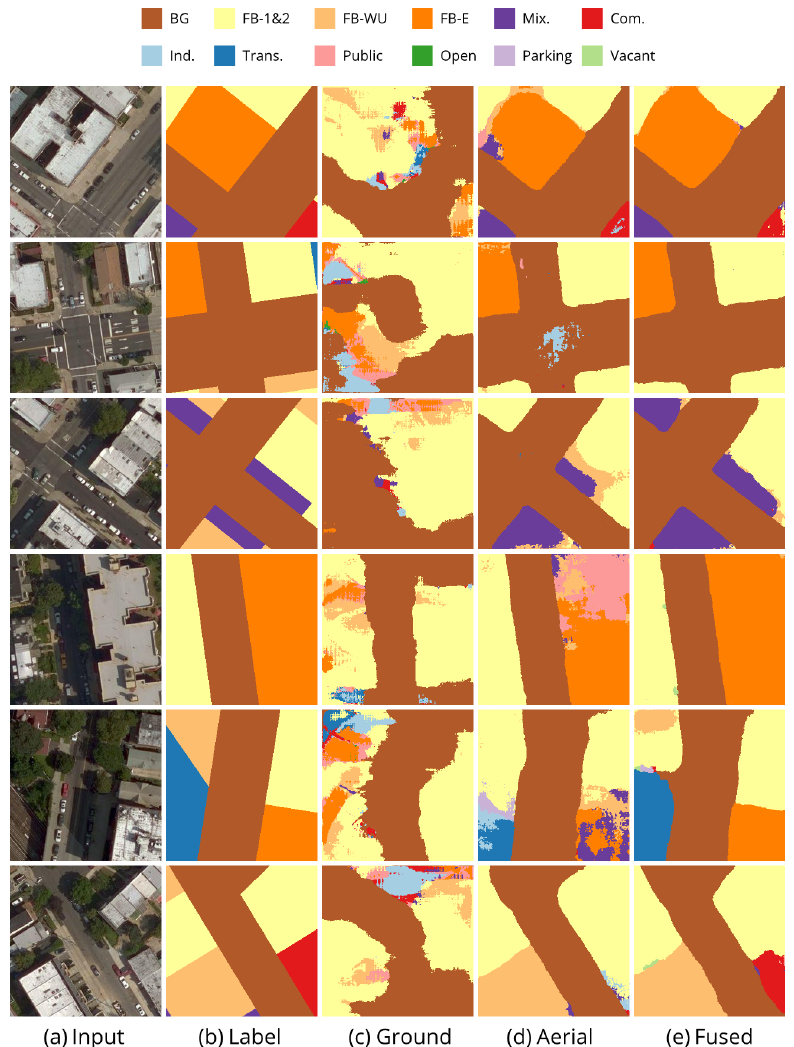
Figure 8. Segmentation results of the three comparative studies. The first three rows are the evaluation results on Brooklyn validation set, and the others are results on Queens test